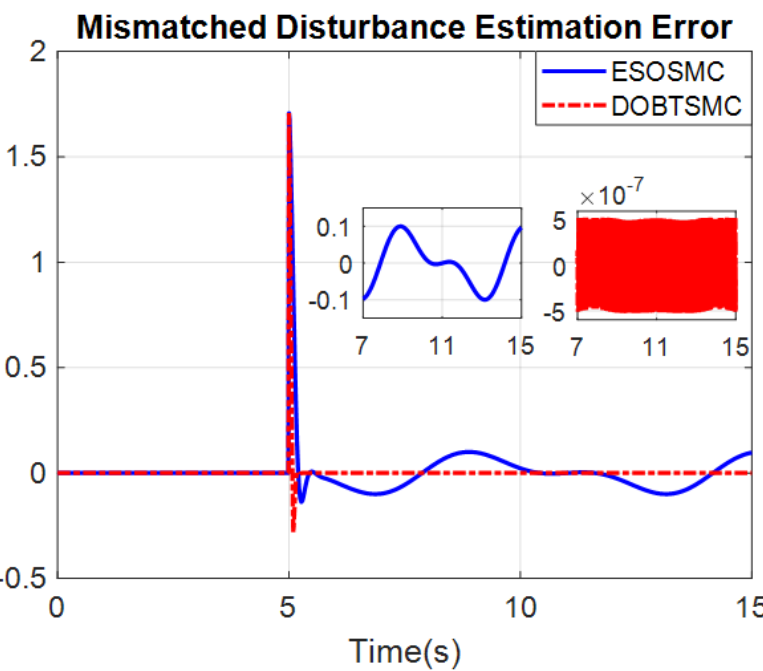
Figure 4. Mismatched disturbance estimation error of ESOSMC and DOBTSMC.